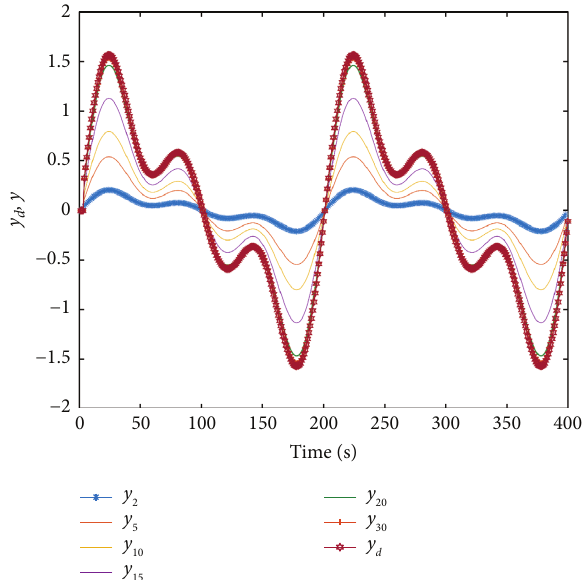
Figure 4: Output versus reference trajectory curve without actu- ator